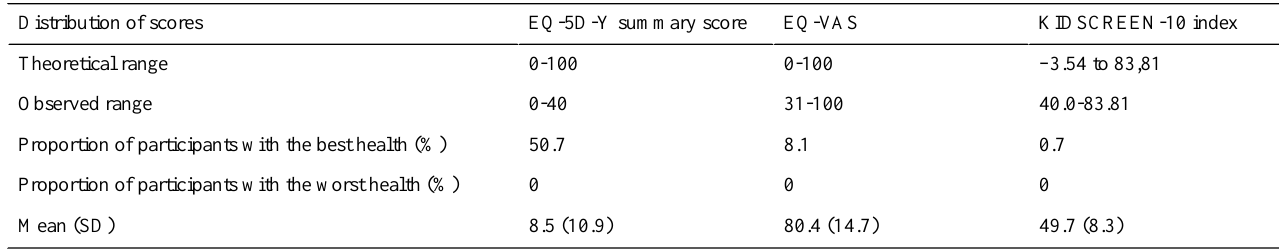
Table 4. Distribution of the EuroQol-5D-Youth (EQ-5D-Y) summary score, EuroQol-Visual Analog Scale (EQ-VAS), and KIDSCREEN-10